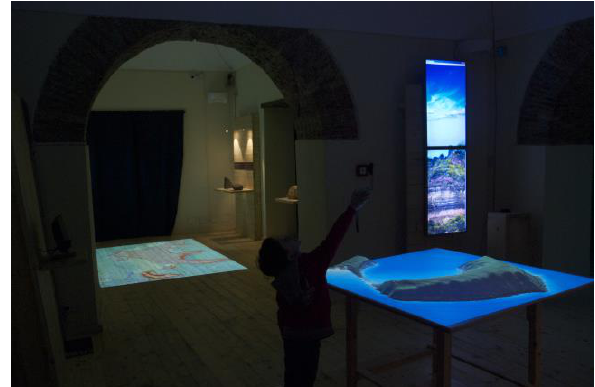
Figure 21. Video projection mapping on model produced by tridimensional